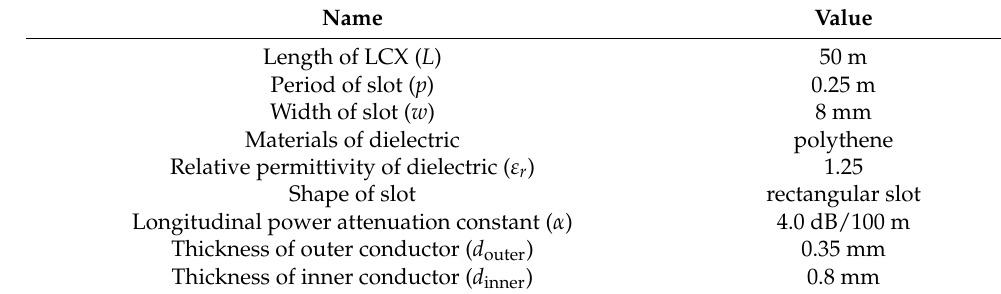
Figure 5. Description of the measurement: ( a ) the tunnel scenario used for measurement; ( b ) cross section view of the tunnel; ( c ) connection diagram of LCX MIMO system; ( d ) receiving antenna location. Table 4. Parameters of Table 3. Parameters setup of measurement scenario.